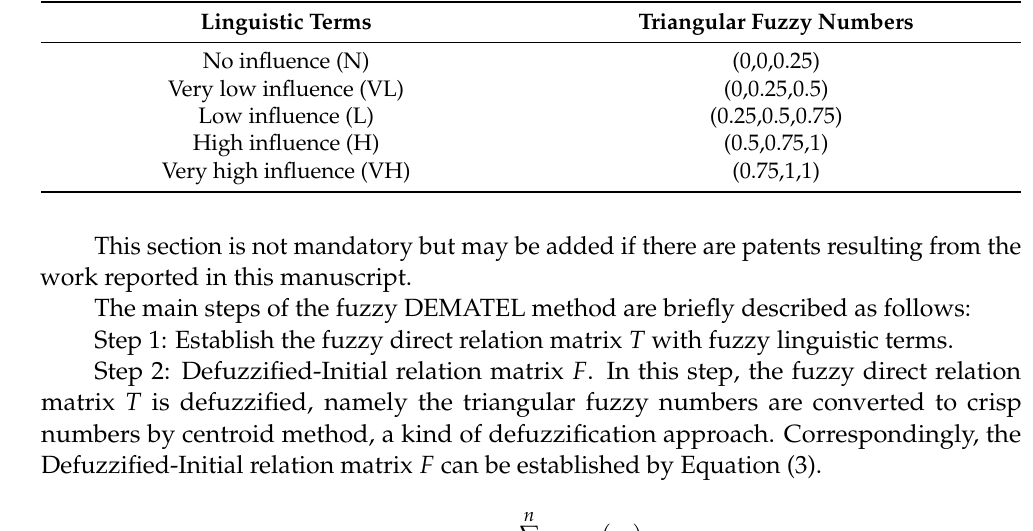
Table 2. Correspondence between the linguistic terms and triangular fuzzy numbers.